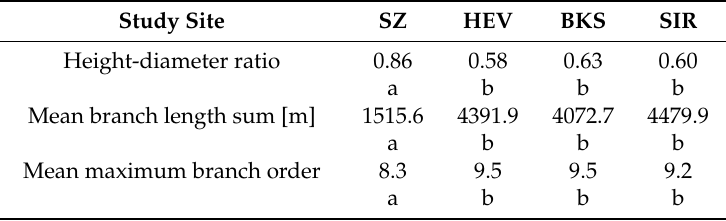
Table A1. Additional tree morphological traits. Different letters indicate significant differences (Tukey-HSD, p < 0.03) between study sites. SZ = Schattiner Zuschlag (long term unmanaged), HEV = Hevenbruch (short